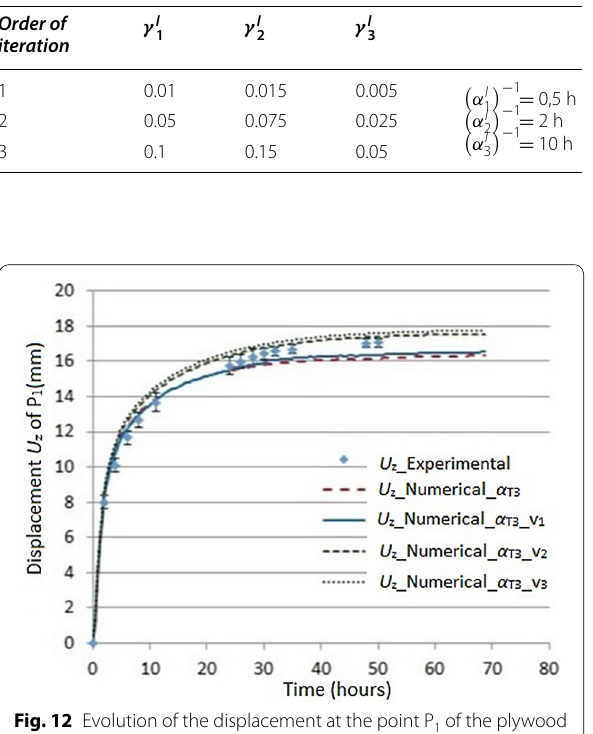
Fig. 12 Evolution of the displacement at the point P 1 of the plywood according to the variation of viscosity parameters (scenario 2)